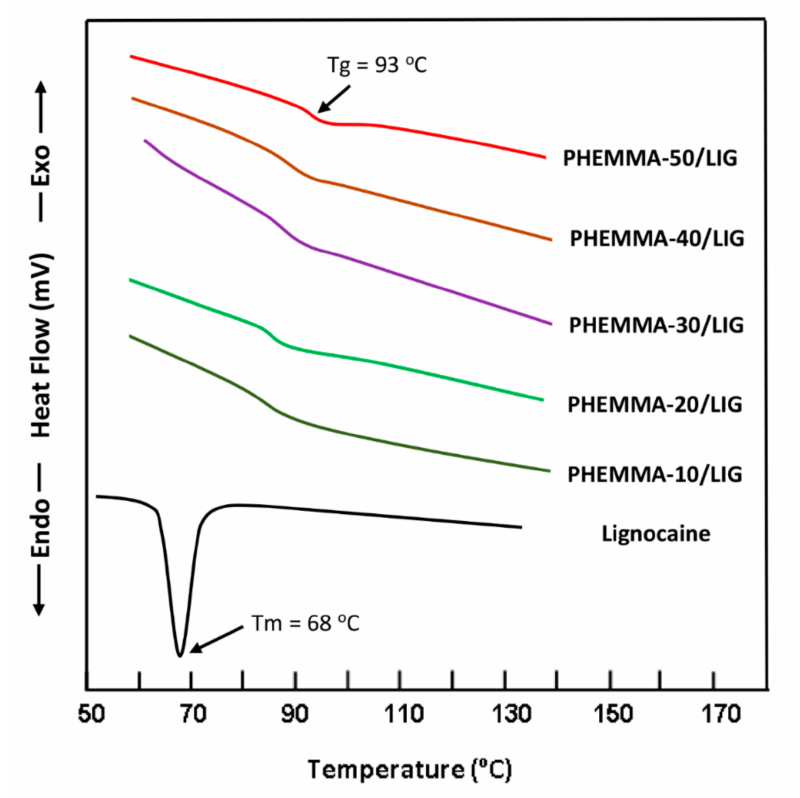
Figure 3. DSC thermograms of PHEMMA / LIG with di ff erent MMA